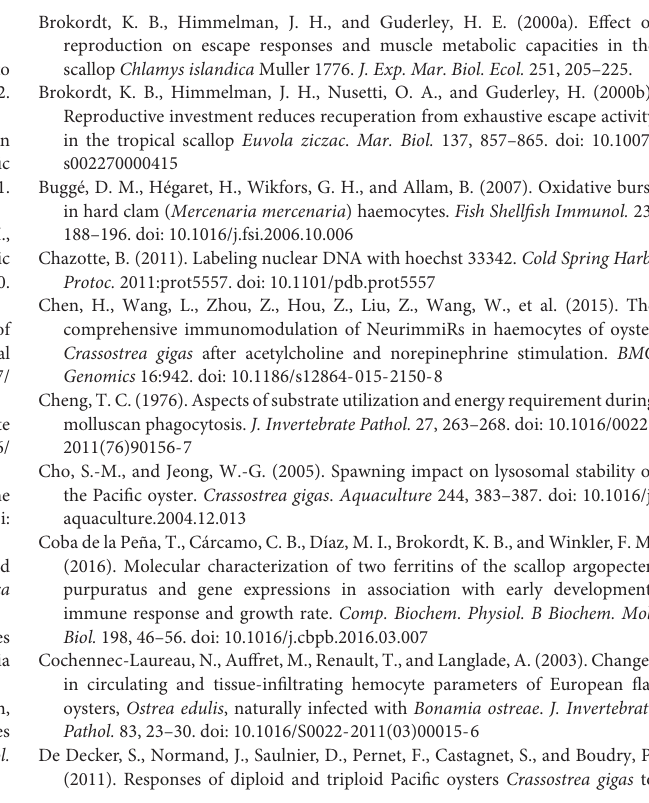
FIGURE S1 | Validation of whole hemocytes antibody detection by Western blot and Immunofluorescence. (A) , Determination of antibody specificity against total protein extract from hemocytes 1. SDS PAGE, 2. Western blotting. (B) , merged confocal images for detection of infiltrating hemocytes in scallop gills